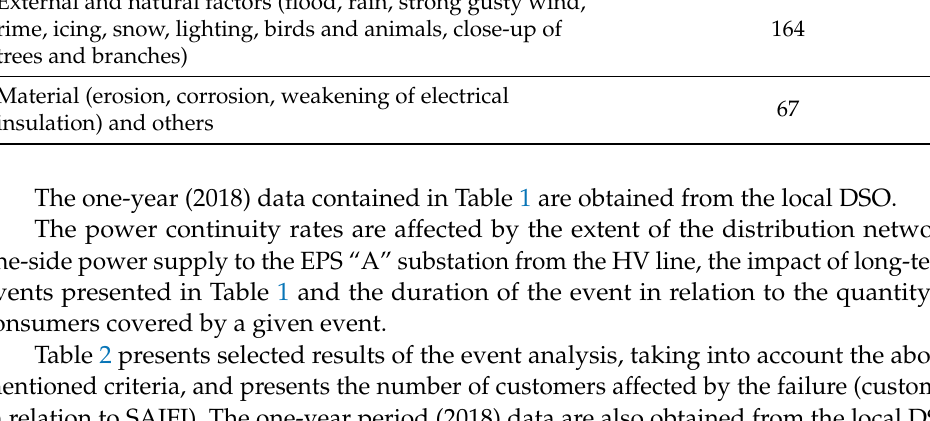
Table 1. List of the failure events in lines of the considered network that occurred in 2018.